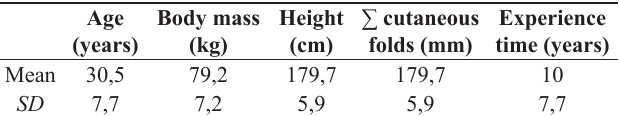
Table 1. General characteristics of the sample, mean ± standard devi- ation ( SD ); n = 12.